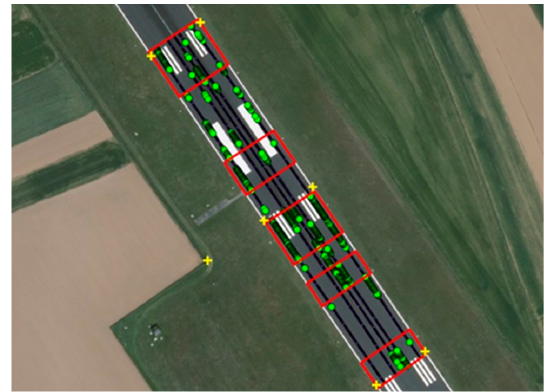
Figure 2. Subareas of the process in the touchdown zone.